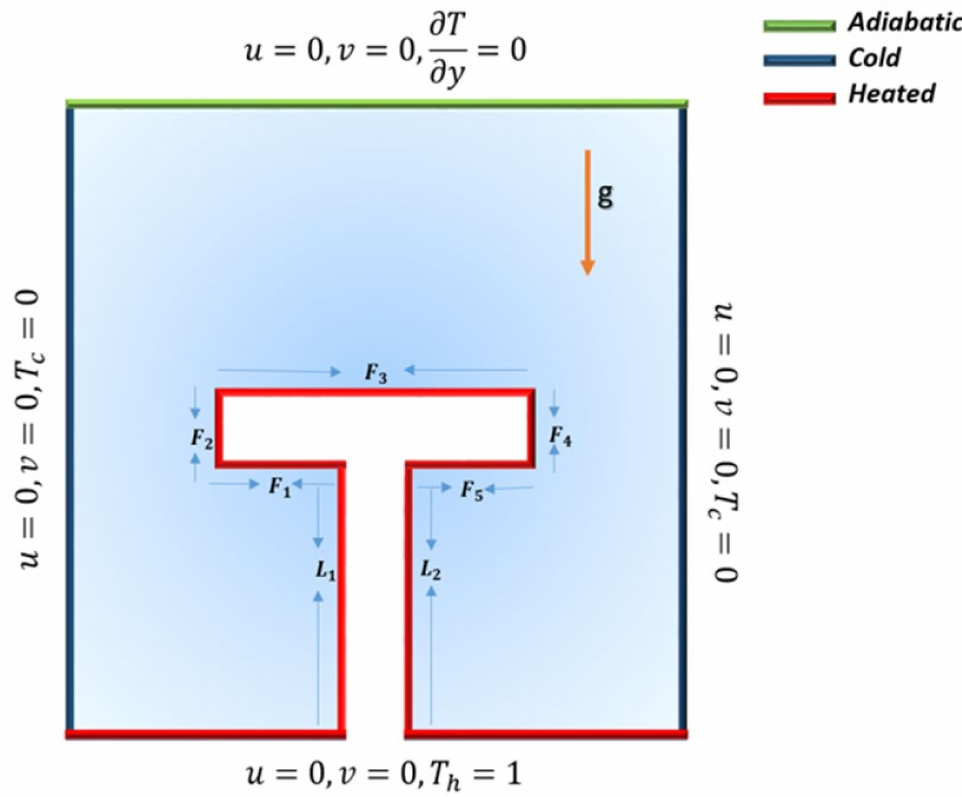
Figure 1. Graphical illustration of the